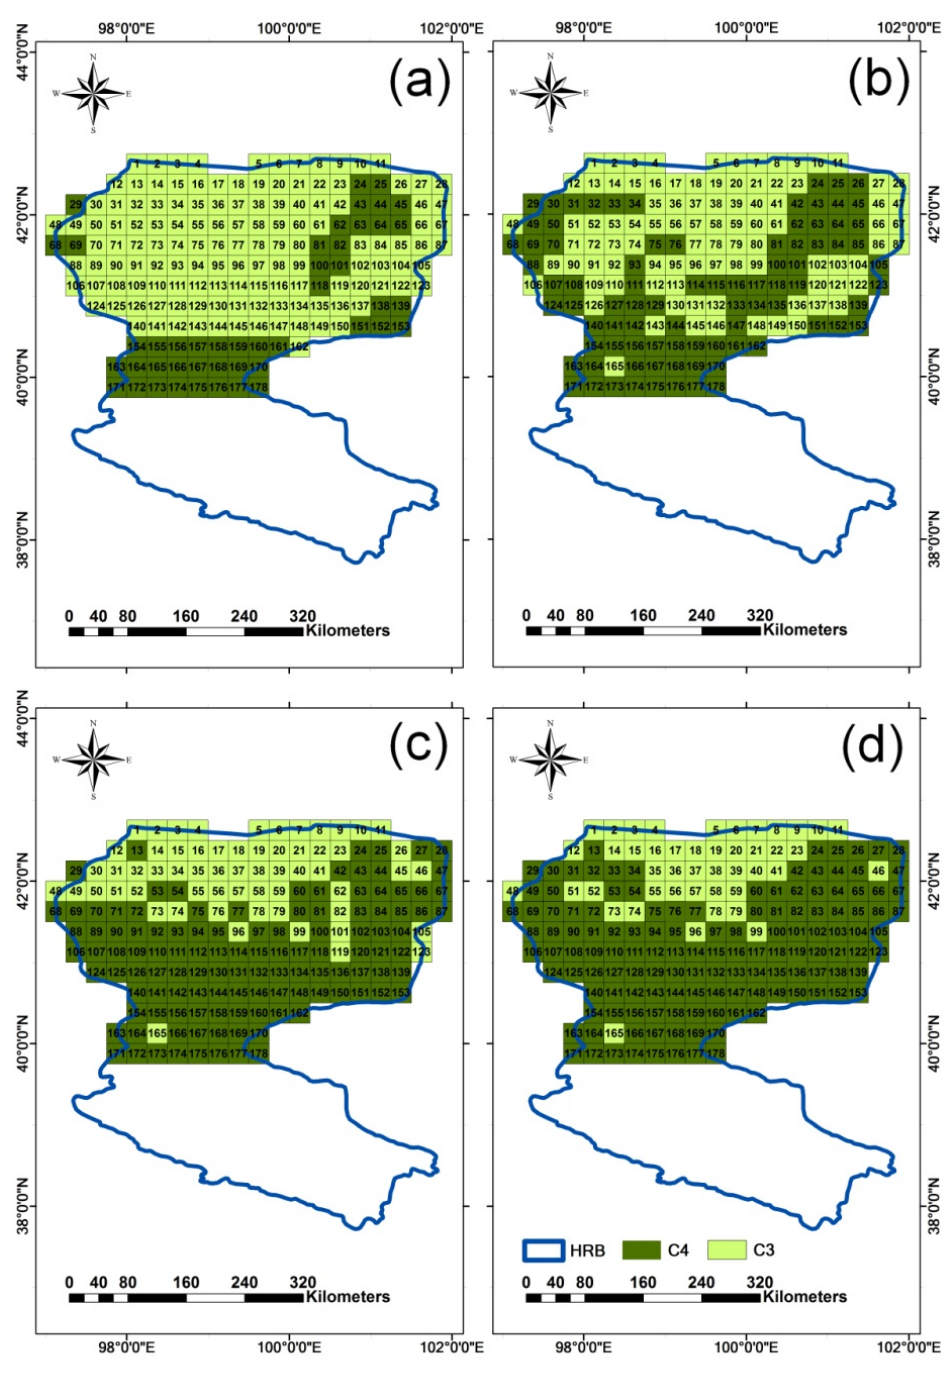
Figure 5. Potential C3 dominant areas determined by ( a ) normalized cumulative NDVI (method 1), ( b ) maximum NDVI (method 2); and ( c ) significant correlation with precipitation (method 3); and ( d ) overlapping C3 dominant areas of (b) and